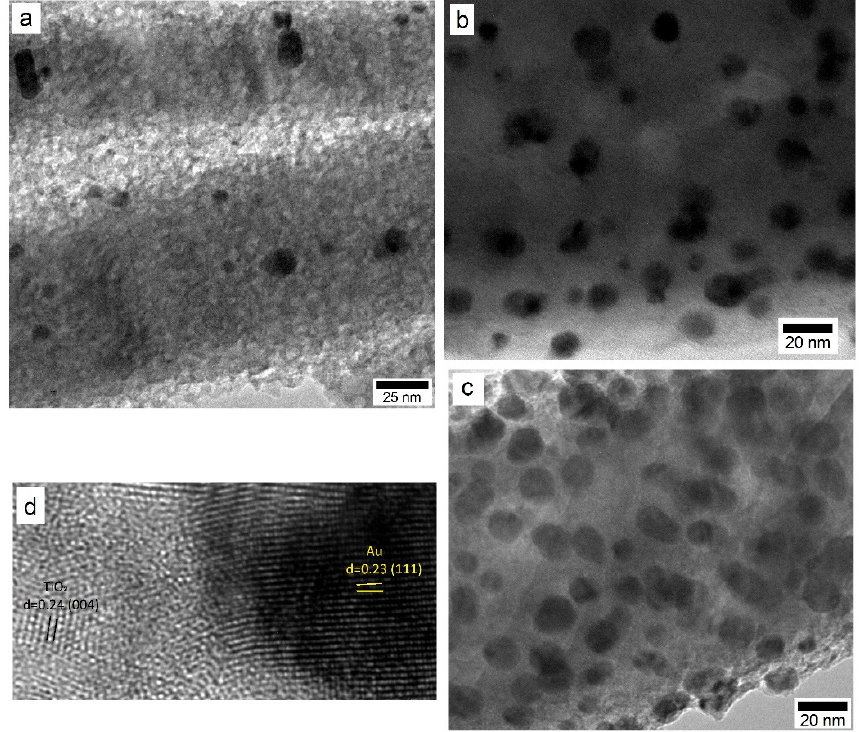
Figure 4. TEM micrographs of Au/TiO 2 system with Au NP from sputter deposition for ( a ) 3 s, ( b ) 6 s, and ( c ) 10 s. ( d ) Lattice structure of Au NP and TiO 2 film.